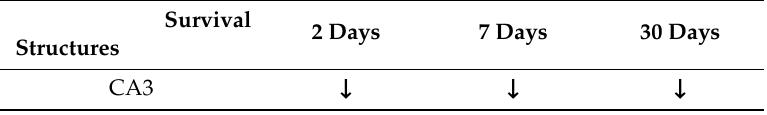
Table 5. Changes in the expression of the Alzheimer’s disease-associated α -secretase gene in the CA3 of the hippocampus at di ff erent times after experimental brain ischemia. Survival 2 Days 7 Days 30 Days Structures CA3 ↓ ↓ ↓ Expression: ↓